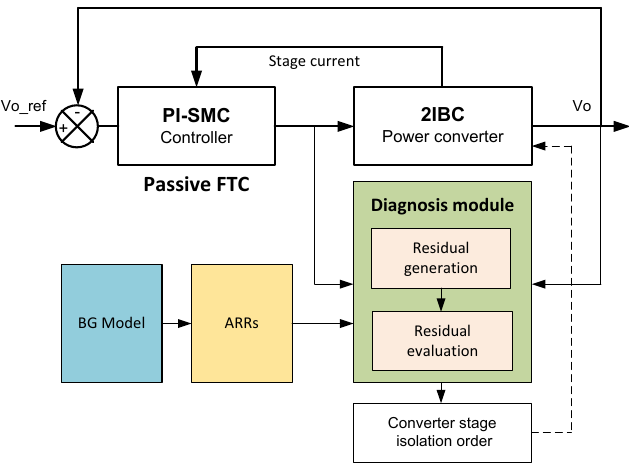
Figure 3. The supervision scheme including the passive fault tolerant